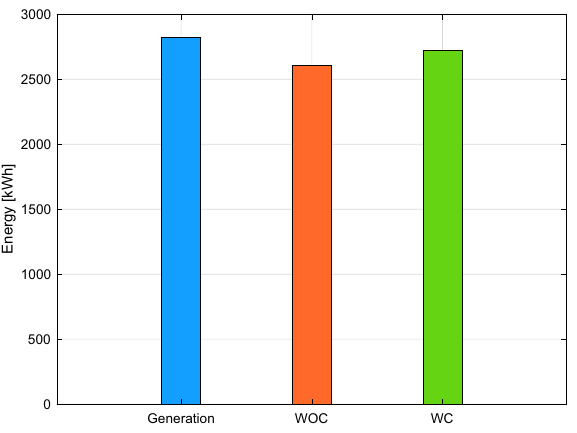
Figure 6. Generation, energy consumption with and without coordination throughout the day.